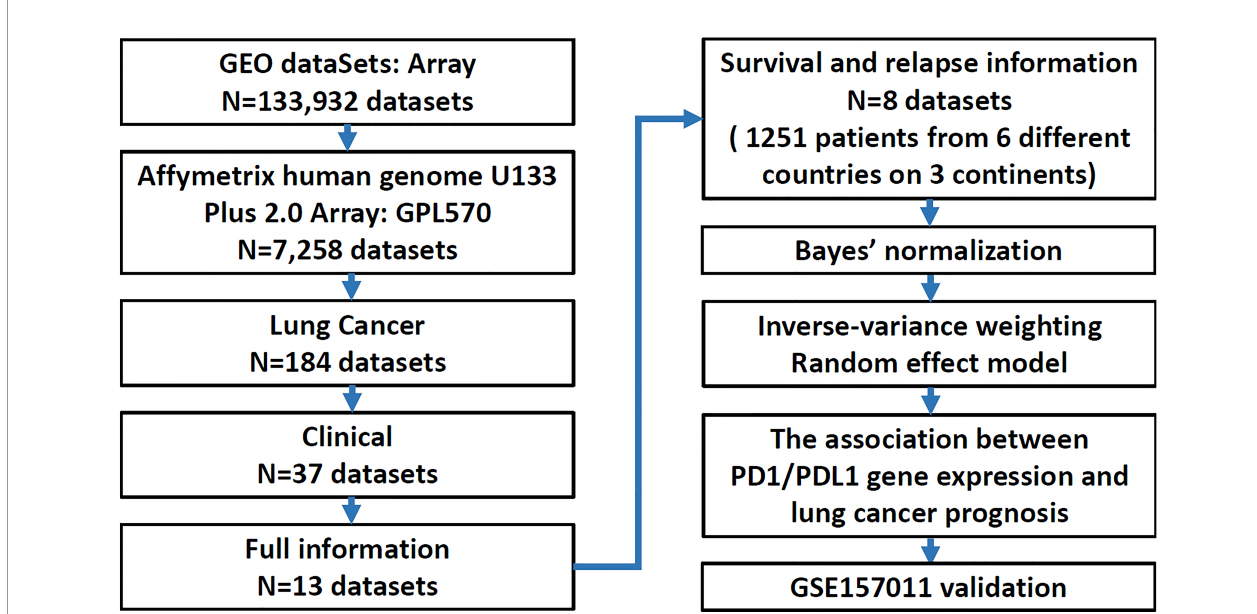
FIGURE 1 | Flow chart summarizing the search process for the identi fi cation of eligible